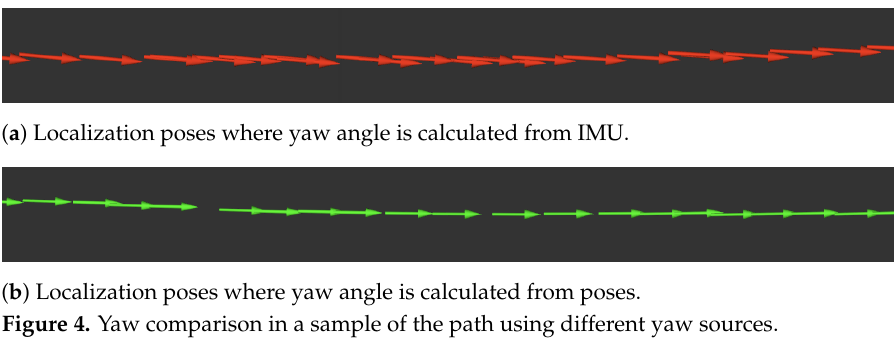
Figure 4. Yaw comparison in a sample of the path using different yaw sources. The last source of odometry included on the Kalman Filter is the wheel